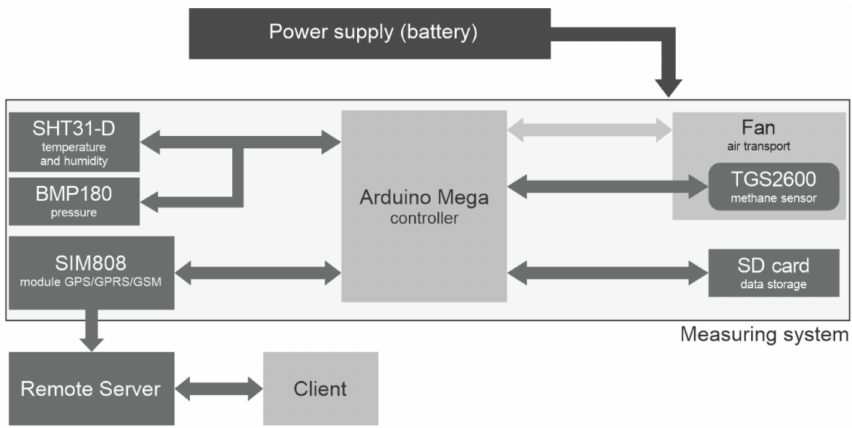
Figure 1. System architecture. The arrows represent the communication among the different elements of the